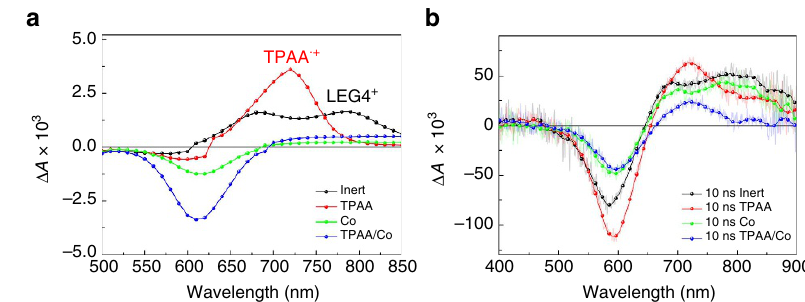
Figure 4 | Photo-induced and transient absorption. Photo-induced absorption spectra ( a ) and transient absorption spectra ( b ) of LEG4-sensitized TiO 2 employing four different electrolytes: inert (0.1M LiClO 4 , 0.2M 4-tert butylpyridine (TBP)), TPAA (0.1M TPAA, 0.1M LiClO 4 , 0.2M TBP), Co (0.1M LiClO 4 , 0.2M TBP, 0.22M Co(bpy) 3 (PF 6 ) 2 and 0.05M Co(bpy) 3 (PF 6 ) 3 ) and TPAA/Co (0.1M TPAA, 0.1M LiClO 4 , 0.2M TBP, 0.22M Co(bpy) 3 (PF 6 ) 2 , and 0.05M Co(bpy) 3 (PF 6 ) 3 ). The transient absorption spectra were acquired after B 10ns following the excitation of a 600nm laser pulse with an intensity B 0.15mJ to 0.25mJcm (cid:2) 2 .